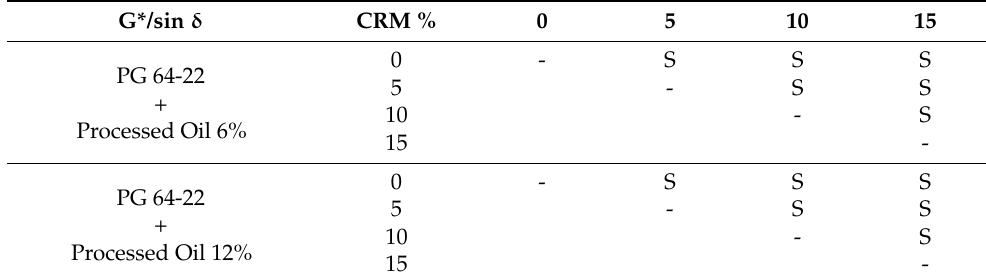
Table 7. Statistical analysis results of G*/sin δ for RTFO aged PG 64-22, with processed oil as a function of CRM content ( α =